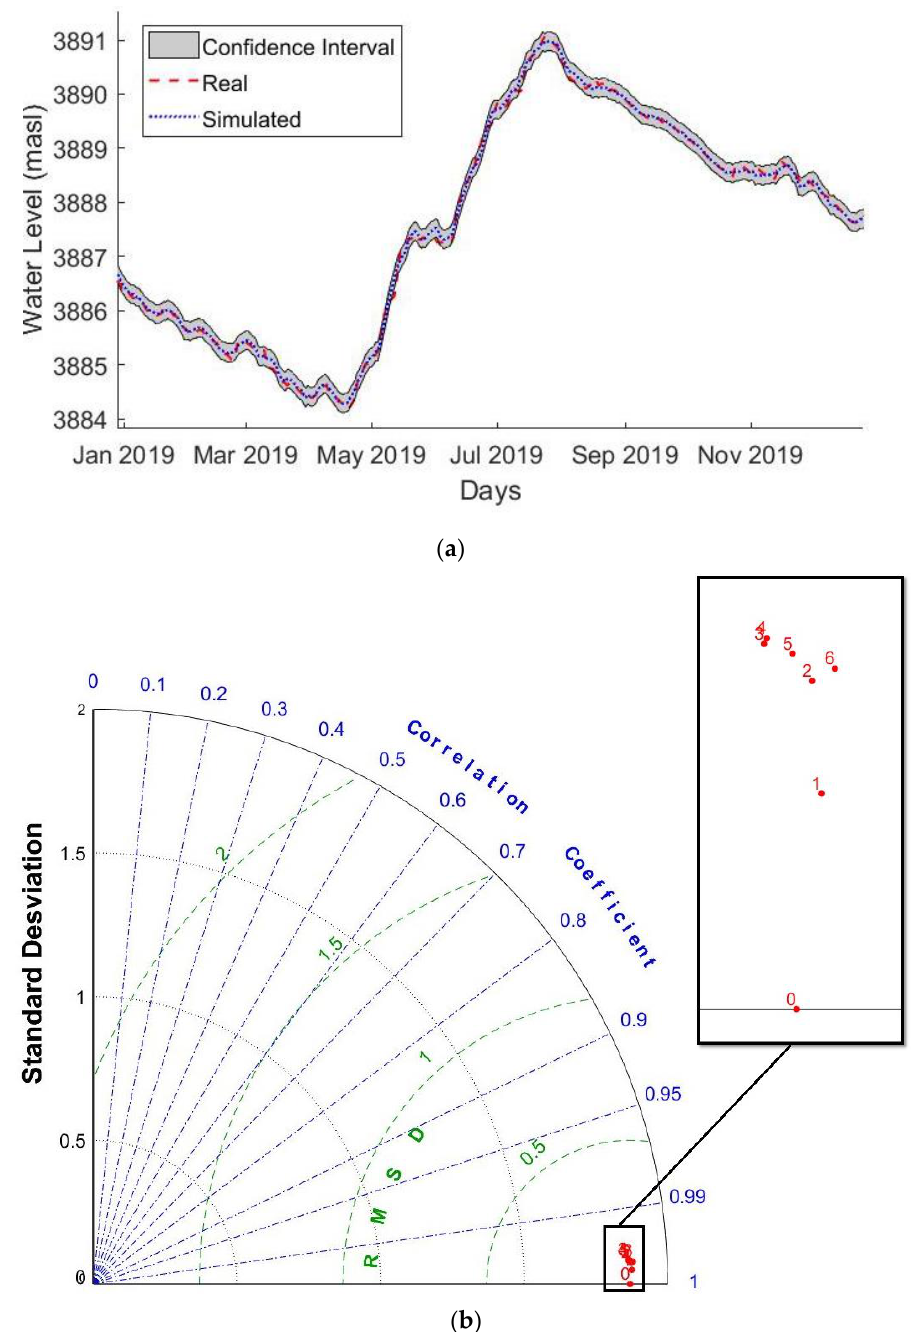
Figure 8. Graphic results of the best prediction results for ANFIS. ( a ) Comparison of the best model ( t + 4) with its confidence interval. ( b ) Taylor diagram. In this diagram, point 0 is real observation data, and 1 to 6 are the models from t + 1 to t + 6 respectively, shown in Table 2.